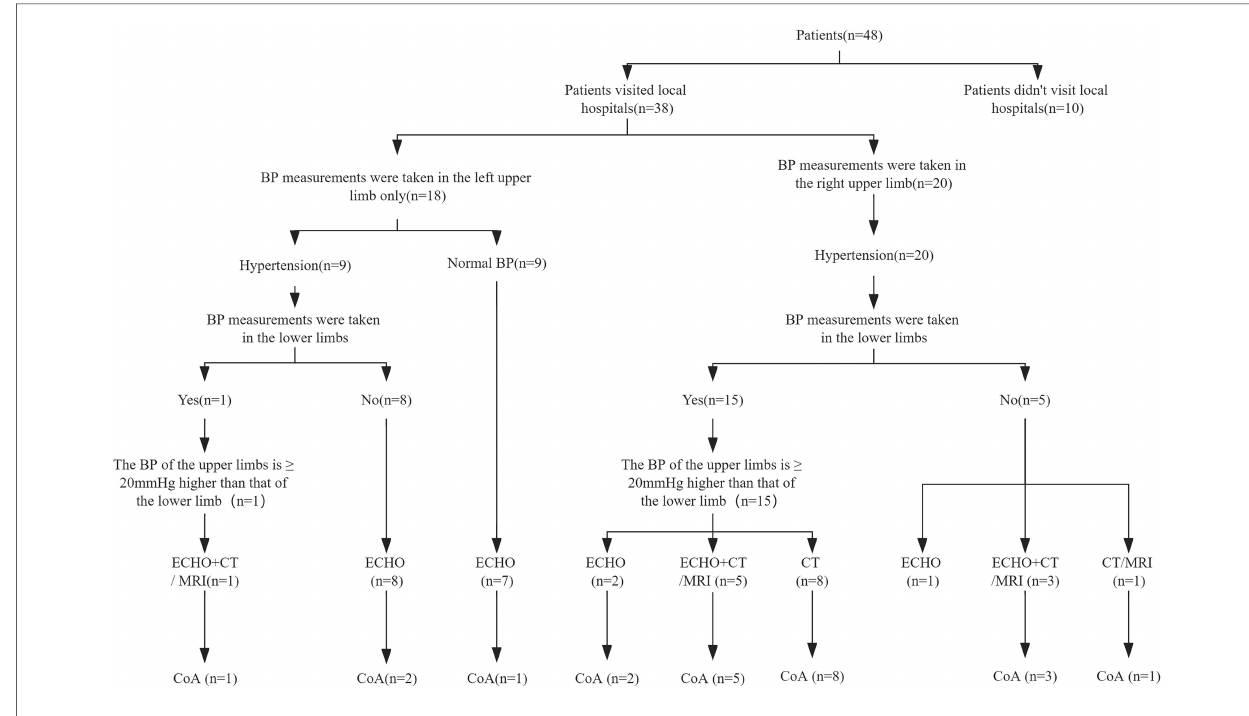
FIGURE 2 Preoperative diagnostic work fl ow at local hospitals, and detection rates of imaging examinations at local hospitals.